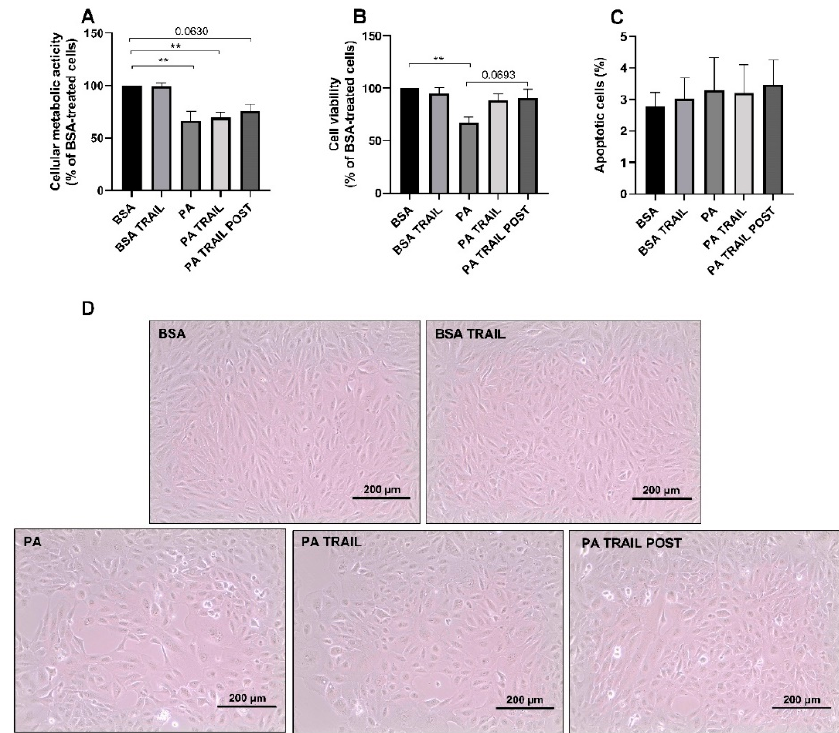
Figure 6. Effect of tumor necrosis factor (TNF)-related apoptosis-inducing ligand (TRAIL) on palmitic acid (PA)-induced cytotoxicity in the recovery experiments. ARPE-19 cell metabolic activity ( A ), viability ( B ) and apoptosis ( C ) assessed after 72 h incubation in growth media carried out after the removal of the following treatments: bovine serum albumin (BSA) in the presence or absence of TRAIL for 72 h following treatment removal (PA + TRAIL POST). In ( D) , representative bright-field